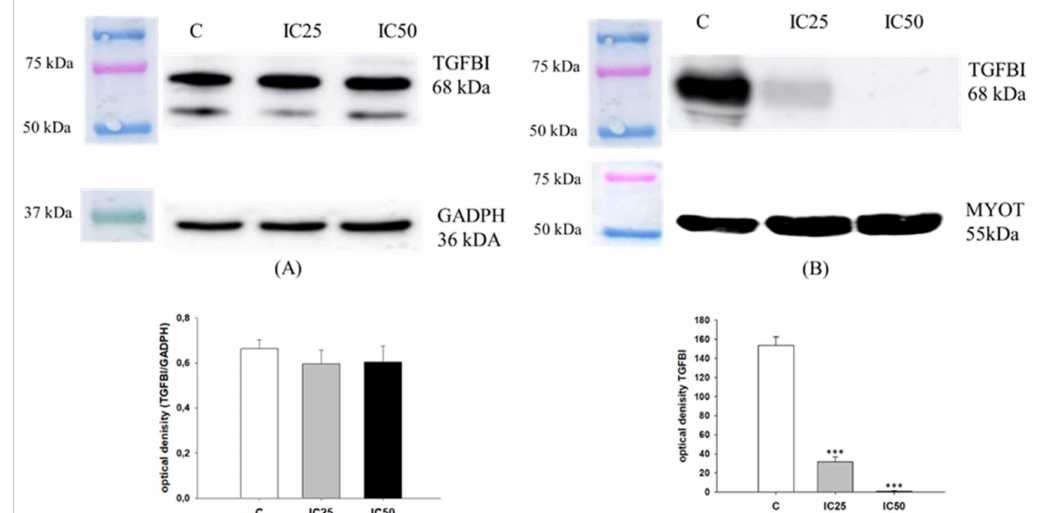
Figure 11. TGFBI protein expression analysis in the W1TR cell line ( A ) and corresponding media ( B ). Protein lysates were prepared after 72 h of cell culture at piperine concentrations at the IC25 or IC50 along with the control untreated cells (C). Proteins were separated using 7% PAGE and transferred to a PVDF membrane, which was then immunoblotted with either primary Ab or HRP-conjugated secondary Ab. A primary anti-GADPH Ab was used as a loading control for the cell lysates. MYOT was used as a loading control for medium from W1TR cell line. The graphs show the results of the densitometry quantification of the Western blot analysis optical density, which is presented as a TGFBI/GADPH ratio ( A ) or TGFBI optical density ( B ). The values were considered significant at *** p <